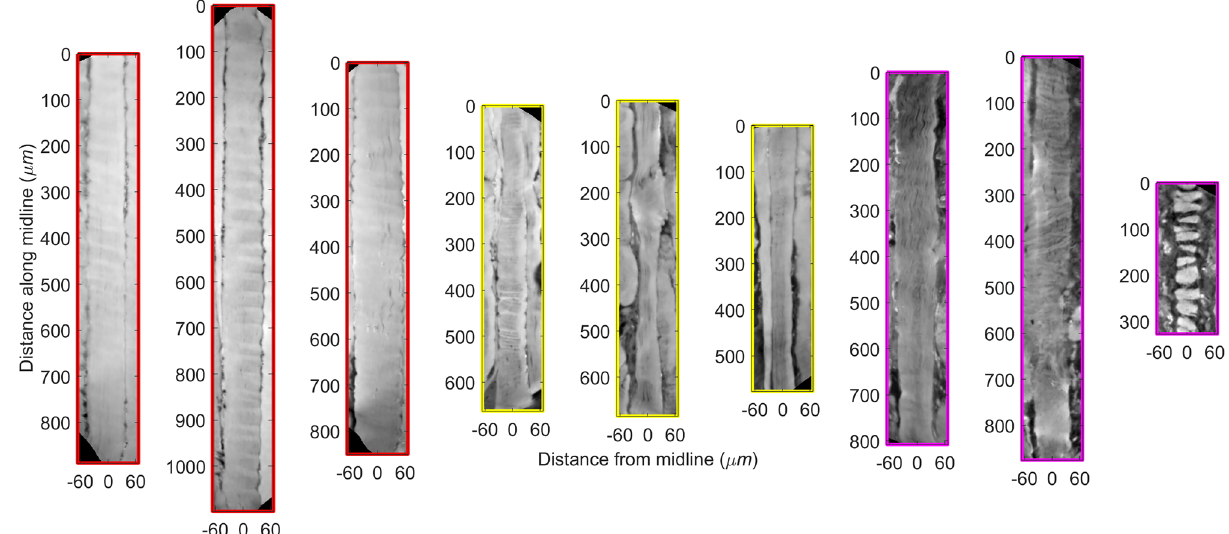
Figure 2. Muscle fiber appearance. Each plot shows the local image appearance around the centerline of selected muscle fibers which corresponds to an unfolded longitudinal cross-section. Three examples from each muscle sample respectively healthy (red), stroke (yellow), and spinal cord injury (purple). Image intensities were sampled in a small plane with a width of approximately 120 microns that follows the muscle fiber centerline, i.e., an unfolded longitudinal cross-section. The figure was created using MatLab software (v2020b) https:// www. mathw orks. com/ produ cts/ new_ produ cts/ relea se202 0b. html.